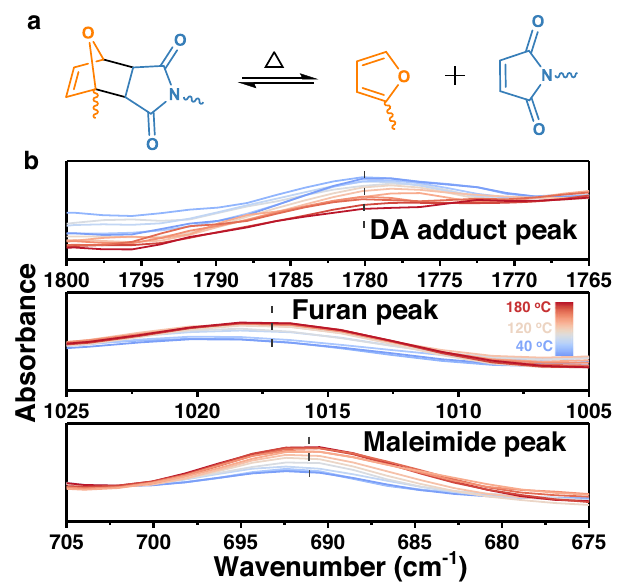
Fig.5|DynamicnatureofDCCNFs.a ThereversibleDAcycloadditionreaction.At low temperatures, furan reacts with maleimide to form DA adduct, while at high temperatures,theretro-DAreactionproceeds; b TherealtemperatureFTIRspectra of DCCNF-60C from 40°C to